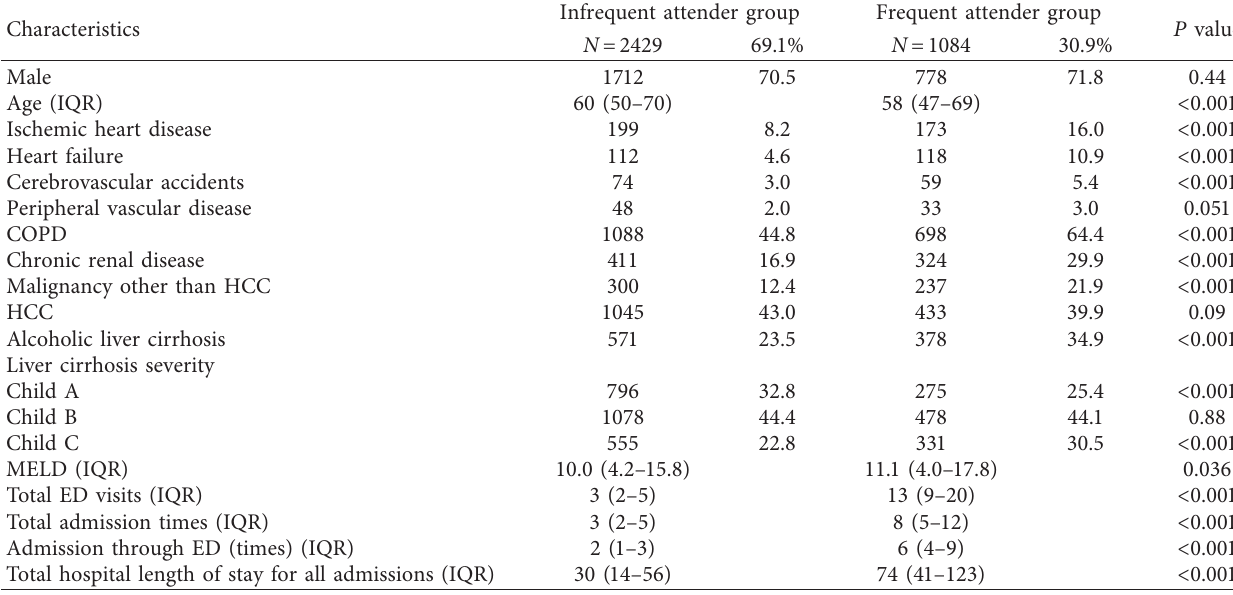
Table 1: Characteristics for cirrhosis-related infrequent attenders and frequent attenders.